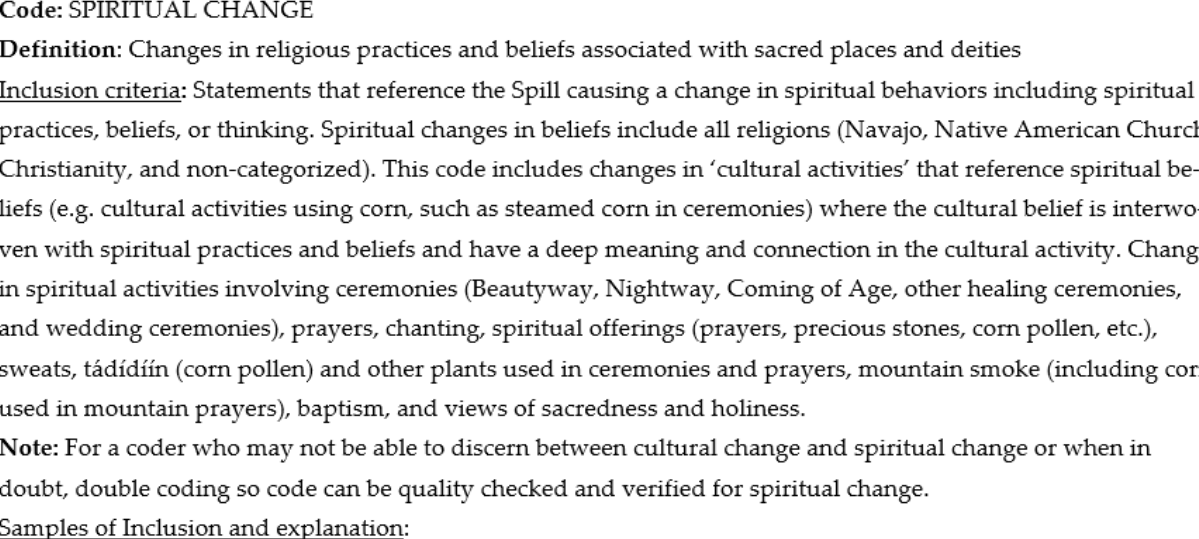
Figure 3. Excerpt from GKMS codebook developed for analysis of focus group narratives, Spiritual Change.